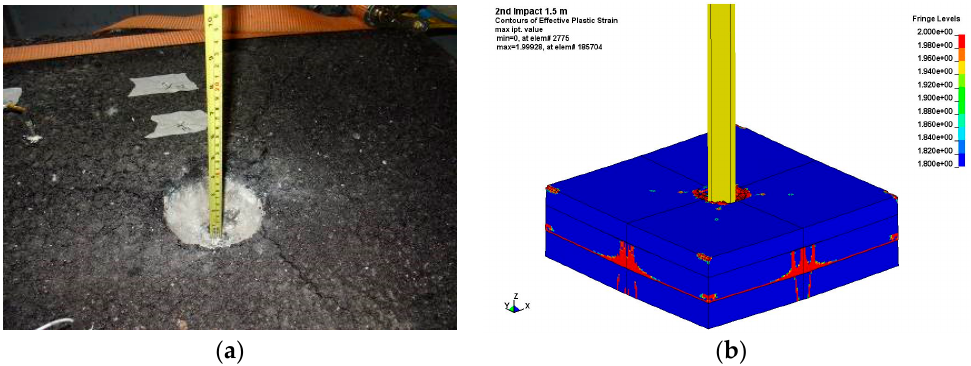
Figure 18. Damage of multi-layer slab after the second impact: ( a ) damage pattern of slab in the laboratory test; ( b ) damage pattern of slab in the numerical simulation.